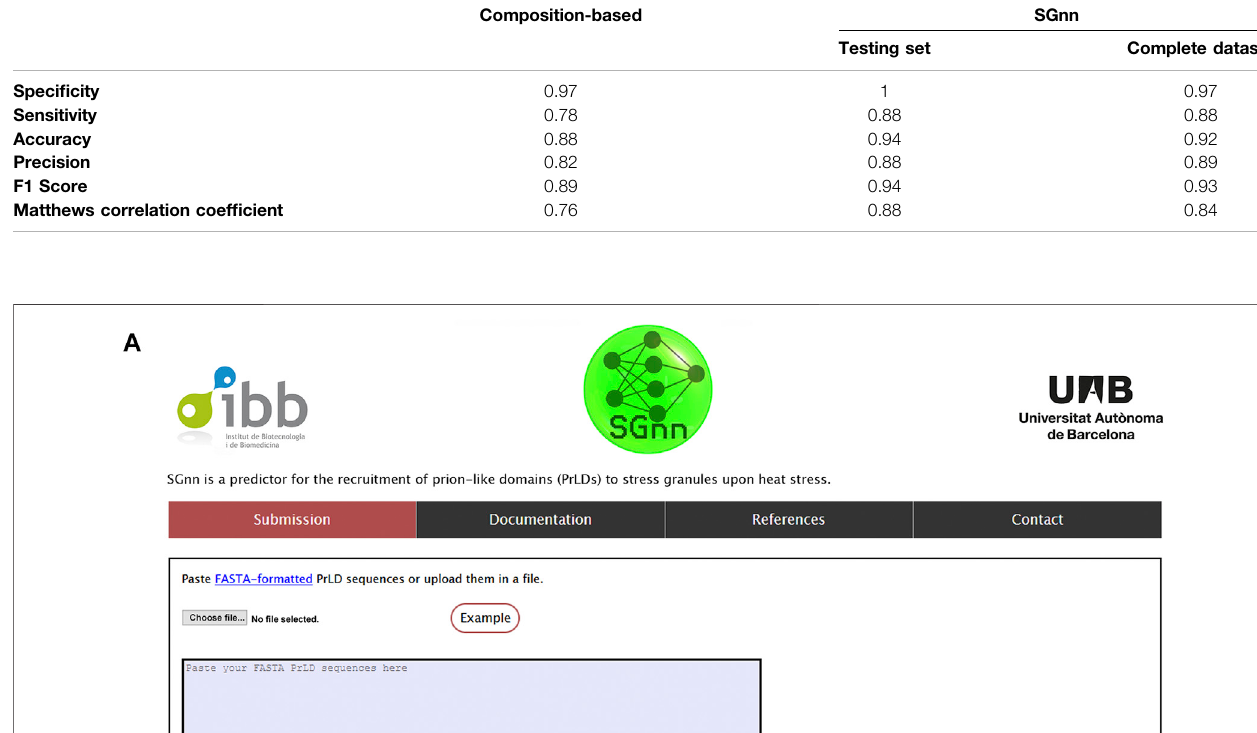
TABLE 2 | Performances of the composition-based and SGnn approaches in predicting heat-induced PrLDs recruitment to SG.